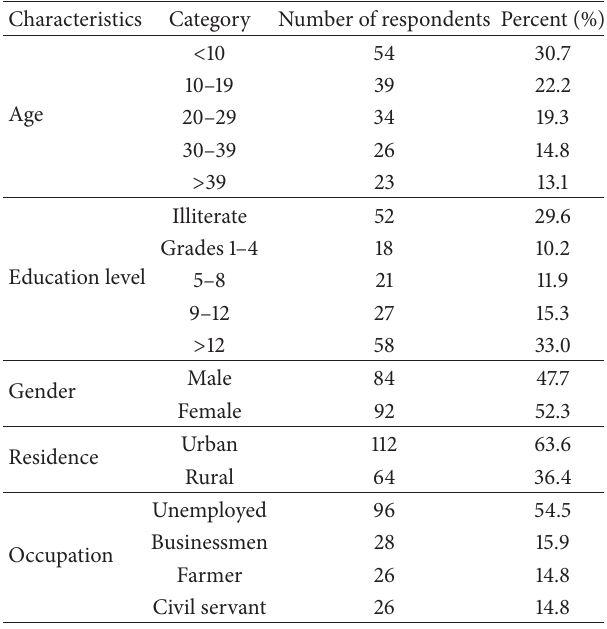
Table 1: Sociodemographic characteristics of the study participants (outpatients), Jimma University Specialized Hospital,